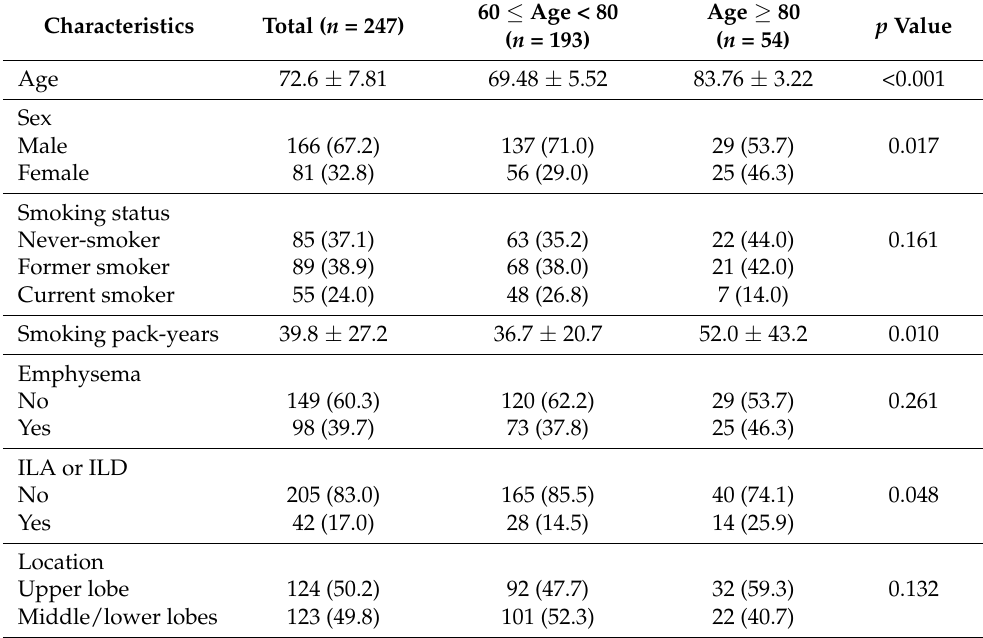
Table 1. Demographics of patients who underwent CT-guided